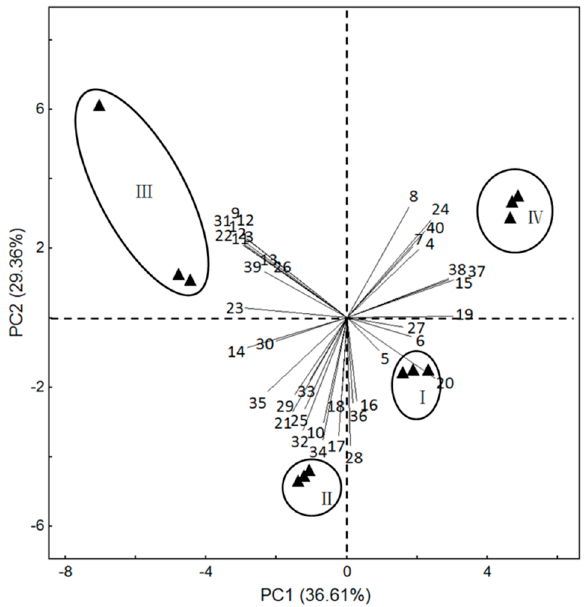
Figure 4. Principal component plot (PC1 vs. PC2 plots) for L. yunnanensis at different stages of growth, showing correlations with volatiles (numbers correspond to those in Table 1). (I) bud stage; (II) initial-flowering stage; (III) full-flowering stage; (IV) end-flower stage.